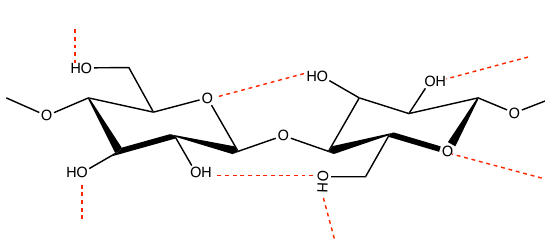
Figure 1. Molecular structure of